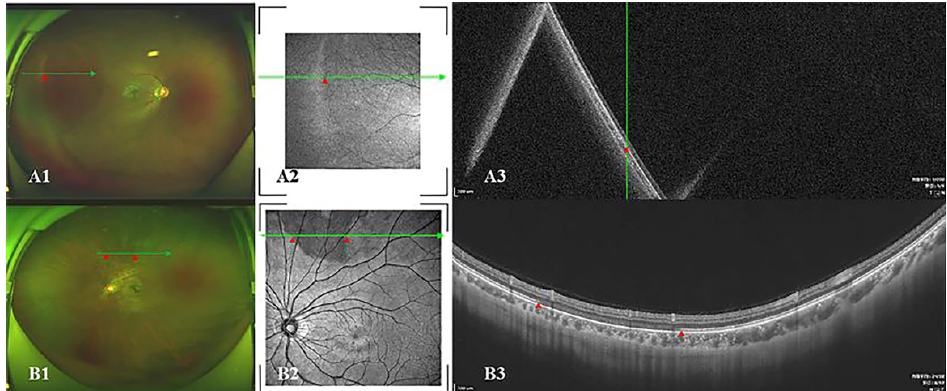
Figure 1. Multimode imaging of WWOP and DWOP. ( A1 – A3 ). One patient with WWOP. On the left of the red triangle, the ultra-wide color fundus photograph ( A1 ) shows a hyperpigmented lesion region. The OCT en-face image was hyperreflective. The B-scan image shows that the ellipsoid zone is also hyperreflective. The WWOP is accompanied by DWOP on the right of the red triangle. ( B1 – B3 ). One patient with DWOP. Between the area of the two red triangles, the ultra-wide color fundus photograph ( B1 ) shows a hypopigmented lesion region. The OCT en-face image is hyporeflective. The B-scan image shows that ellipsoid zone had faded or even disappeared. WWOP, white without pressure; DWOP, dark without pressure; OCT, optical coherence tomography.